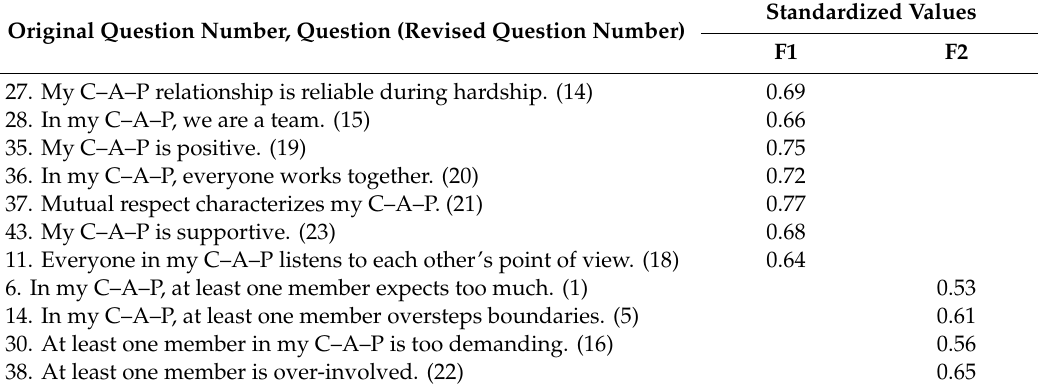
Table 3. Standardized solutions and goodness-of-fit indicators for the C–A–P measures.